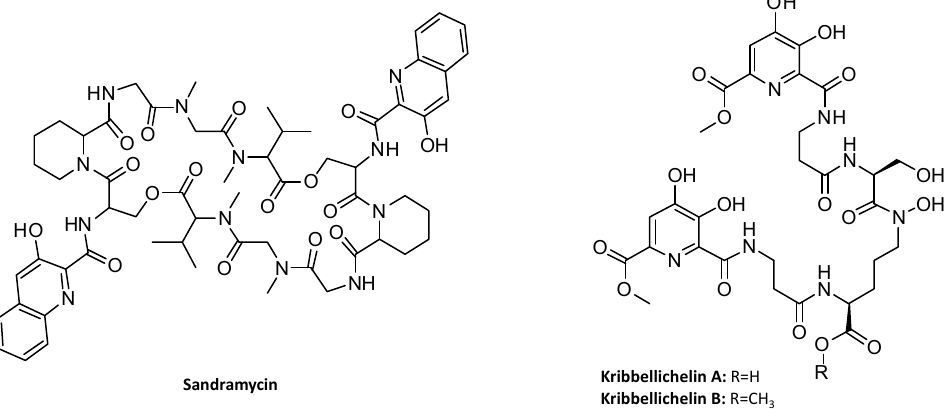
Figure 1. Structures of sandramycin and kribbellichelins A and B.